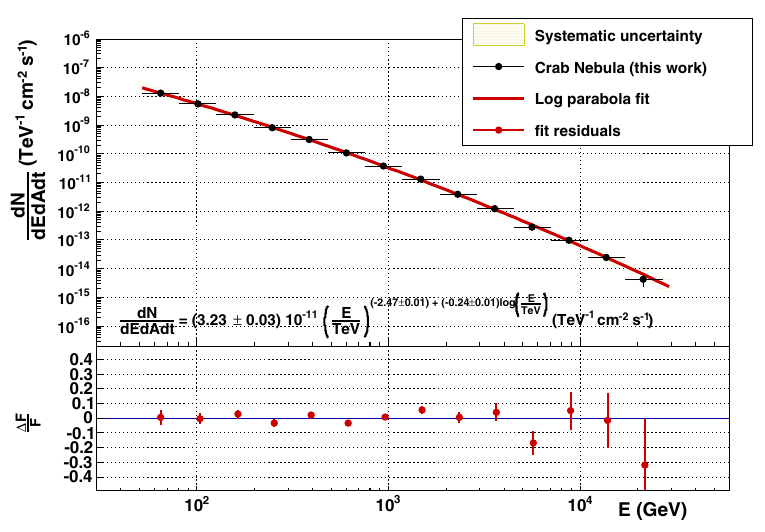
Figure 4. Differential energy spectrum of the Crab Nebula obtained with data recorded by the MAGIC stereoscopic system. 3C 58 is a PWN centered in PSR J0205+6449, one of the highest spin-down pulsars in the sky ( ˙ E = 2.7 × 10 37 erg s − 1 , or 2% of the Crab pulsar’s ˙ E ). The distance and age